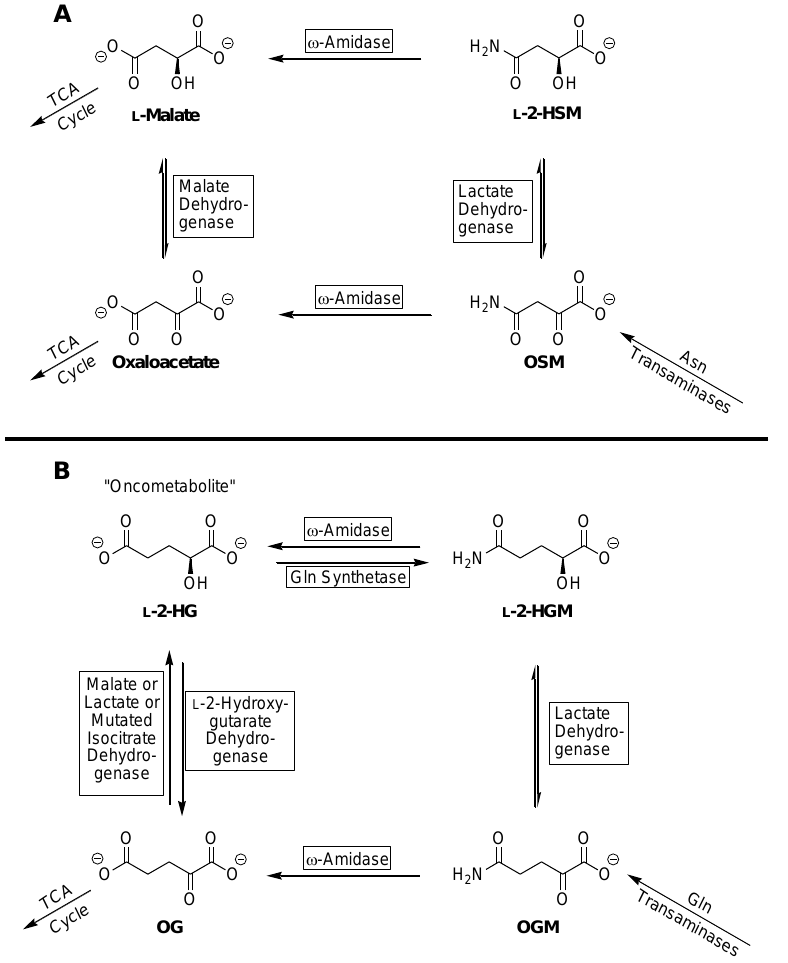
Figure 2. Metabolically important reactions and side reactions involved in the metabolism of 2-oxosuccinamate (2-OSM) ( A ) and 2-oxoglutaramate (2-OGM) ( B ). The asparaginase II pathway (bottom of panel A) and the glutaminase II pathway (bottom of panel B) may be regarded as major metabolic pathways for L -asparagine and L -glutamine, respectively. On the other hand, excessive formation of L -2-HSM and L -2-HGM as side reactions may be regarded as metabolic mistakes, so that repair pathways for their conversion to metabolically useful L -malate/oxaloacetate (Panel A) and 2-OG (Panel B) are required. Not shown is the formation of D -2-HG by mutant IDHs and the possible utilization of this compound as a substrate of GS (Gln Synthetase). For clarity, some cofactors and co-substrates have been omitted from the diagram.